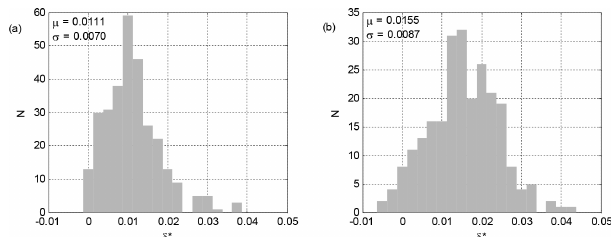
Figure 3. Ratio of cross-polar SNR to co-polar SNR at liquid cloud base measured with Halo Doppler lidar. (a) Distribution of cloud base δ ∗ at Limassol. (b) Distribution of cloud base δ ∗ at Vehmas-